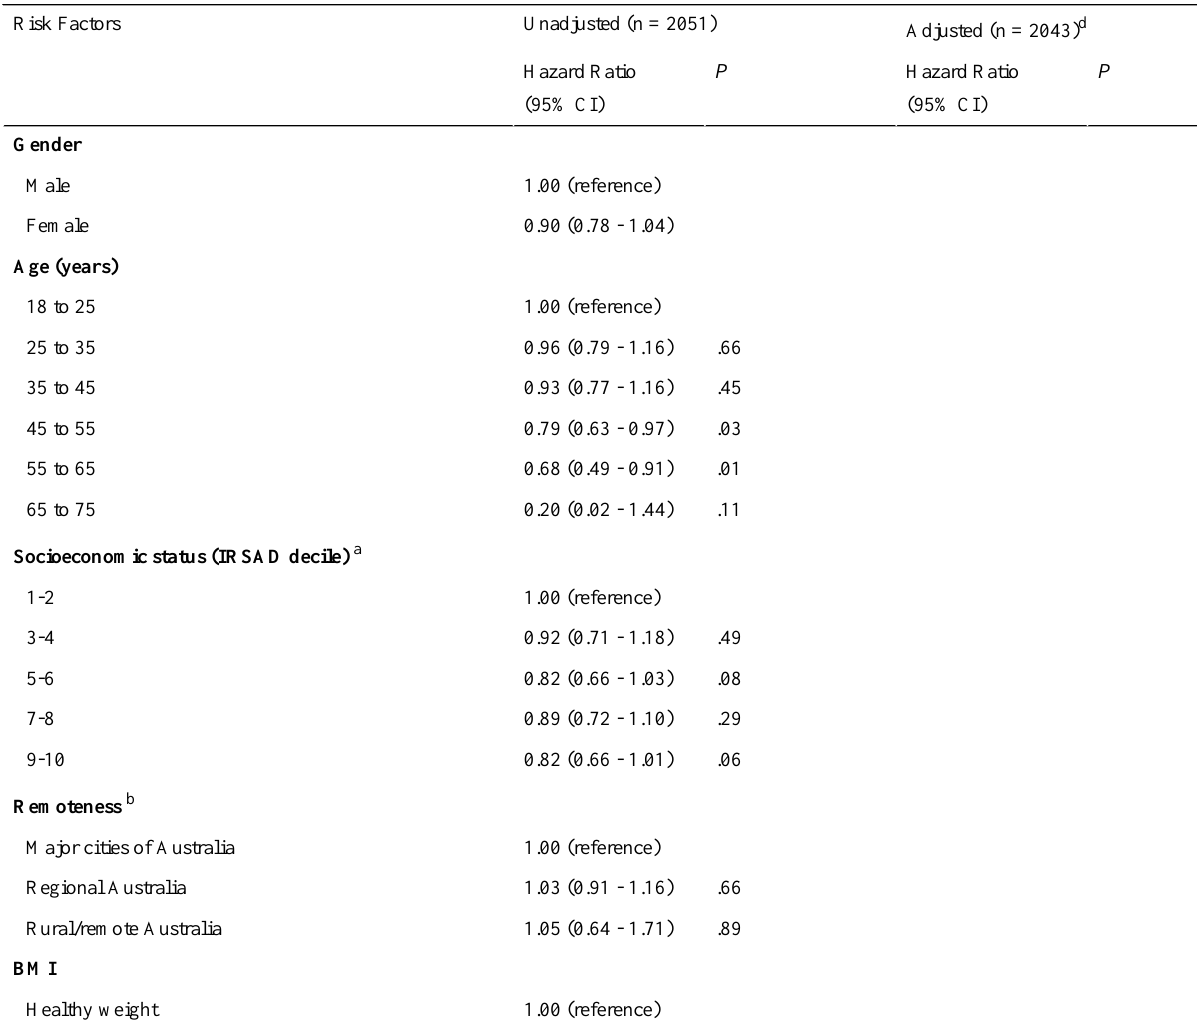
Table 3. Risk of nonusage attrition for 52 week